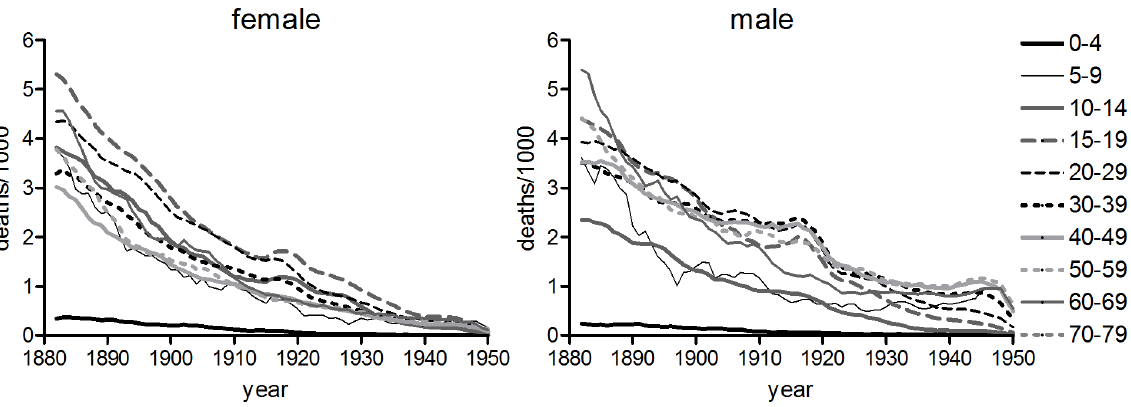
Figure 7. Age-specific tuberculosis mortality in Massachusetts, by period of death. Rates are for respiratory tuberculosis ages 0–14, and for all tuberculosis (predominantly respiratory) at ages 15 + .